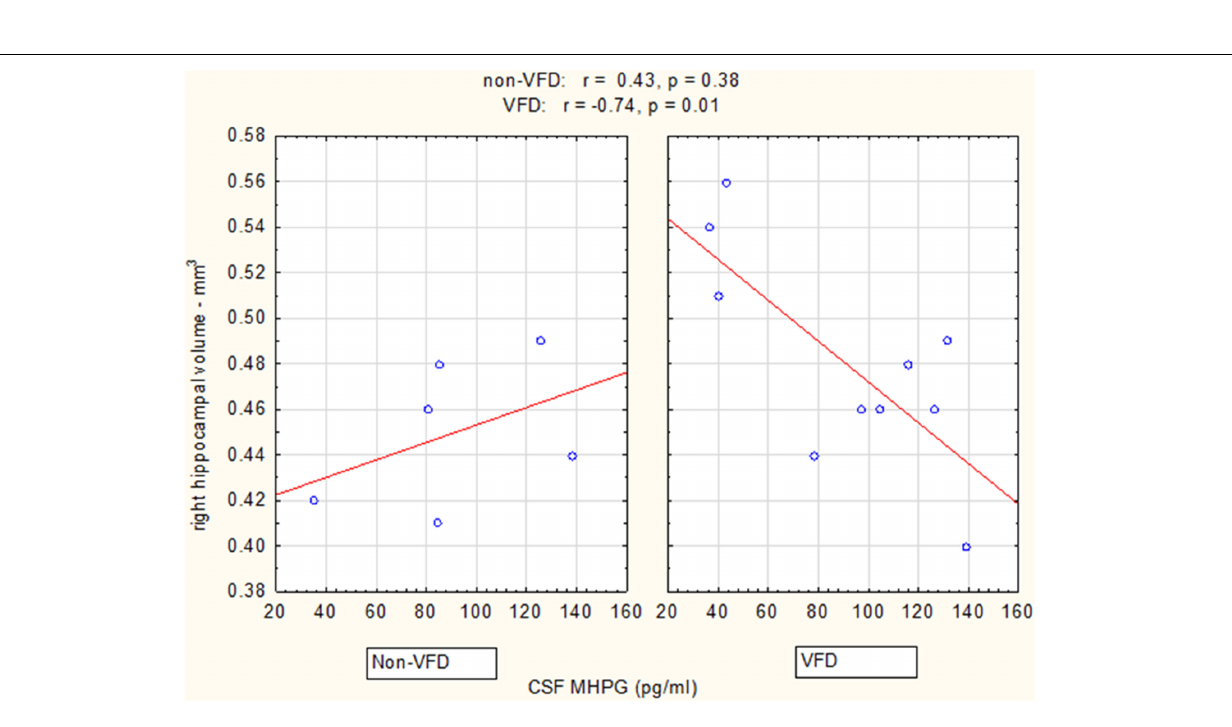
non-VFD subjects [right hippocampal × rearing condition interaction: F (1 , 12) = 5 . 37, p = 0 . 039]. See Pearson’s correlations at the top of the